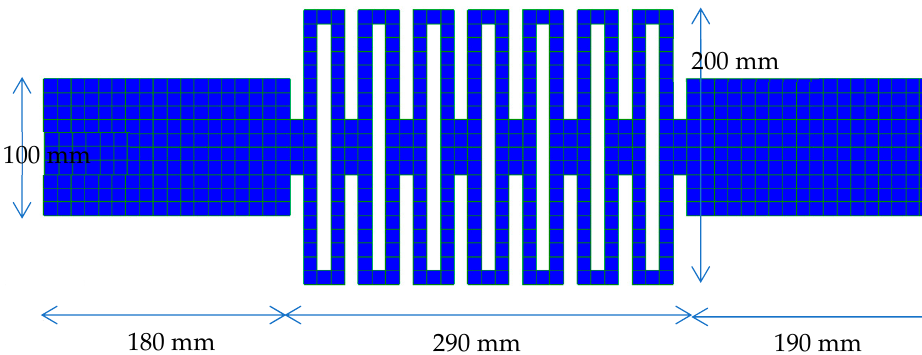
Figure 4. Dimensions of test specimen F-7 (10 mm grids).